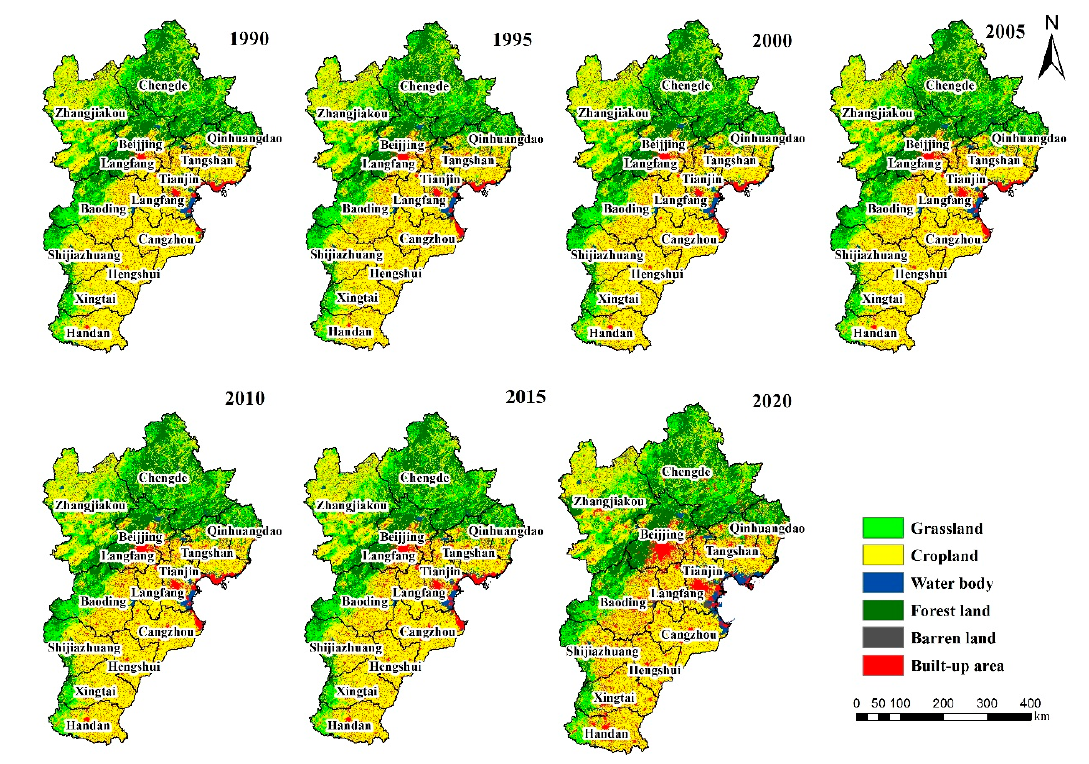
Figure 2. Spatial pattern of land use in the Beijing-Tianjin-Hebei region from 1990–2020. Table 2. Land use transfer matrix in the Beijing-Tianjin-Hebei region during 1990–2020 (km 2